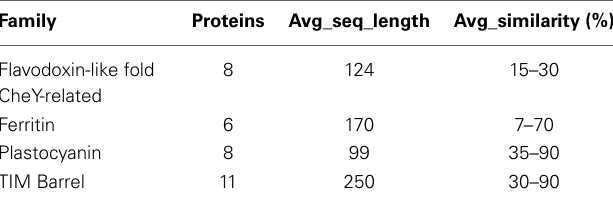
Table 1 | Skolnick’s dataset families.